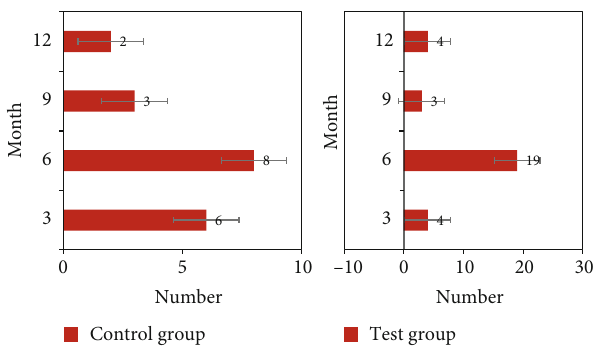
Figure 9: Comparison of pregnancy between the two